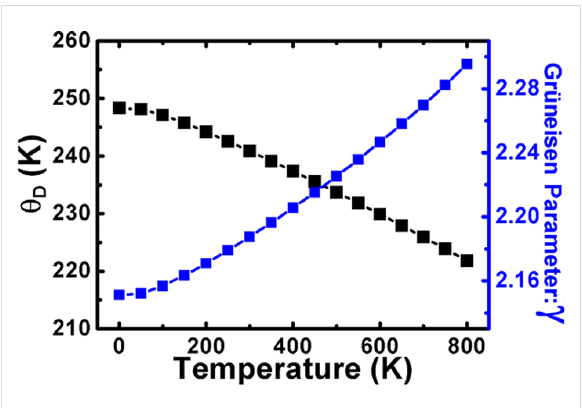
Figure 8: Variation of Debye temperature ( θ D ) and the Grüneisen pa- rameter ( γ ) at different temperature values for the π -SnSe